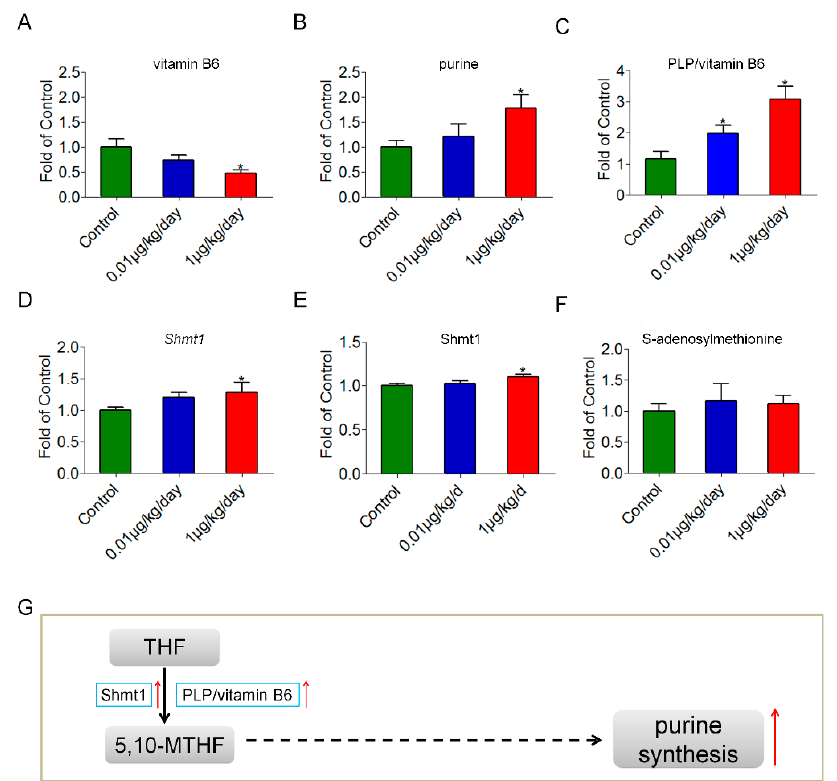
Figure 5. Metabolomic analysis for purine metabolism in mouse liver after low-dose OP treatment.